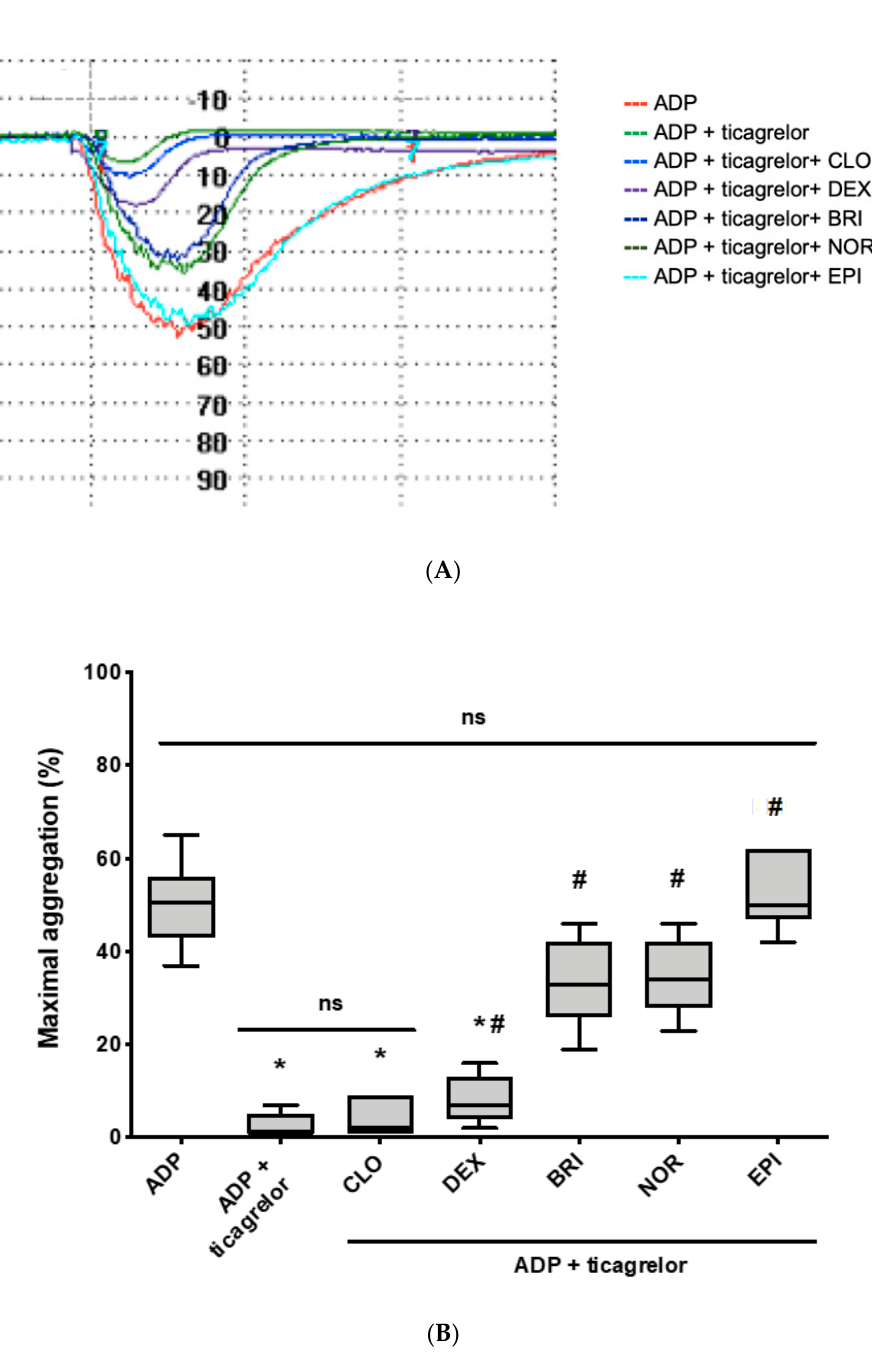
Figure 2. Norepinephrine and brimonidine partially restore ADP-induced platelet aggregation inhibited by ticagrelor, while clonidine and dexmedetomidine are ineffective. Washed platelet aggregation on stimulation with different agonists (10 µM ADP alone or in combination with clonidine (CLO, 10 µM), dexmedetomidine (DEX, 8 µM), brimonidine (BRI, 10 µM), norepinephrine (NOR, 10 µM), or epinephrine (EPI, 10 µM)), in the absence or presence of ticagrelor. ( A ) Typical time-course of platelet aggregation using light transmission aggregometry. ( B ) Comparison of percentage of the maximal aggregation ( n = 7). Boxes represent the interquartile range and the median value, whiskers and the minimum and maximum values observed. All samples were compared with ADP alone (* p < 0.01 vs. ADP alone) or ADP in the presence of ticagrelor (# p < 0.05 vs. ADP + ticagrelor).